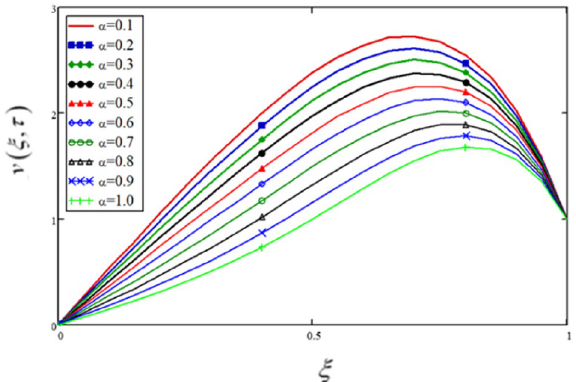
Figure 2. Variations in velocity profile for various values of fractional parameter, the profiles for α = 0.1, 0.2, 0.3, . . . , 1 ( α = 1 is the solution for the integer ordered model).